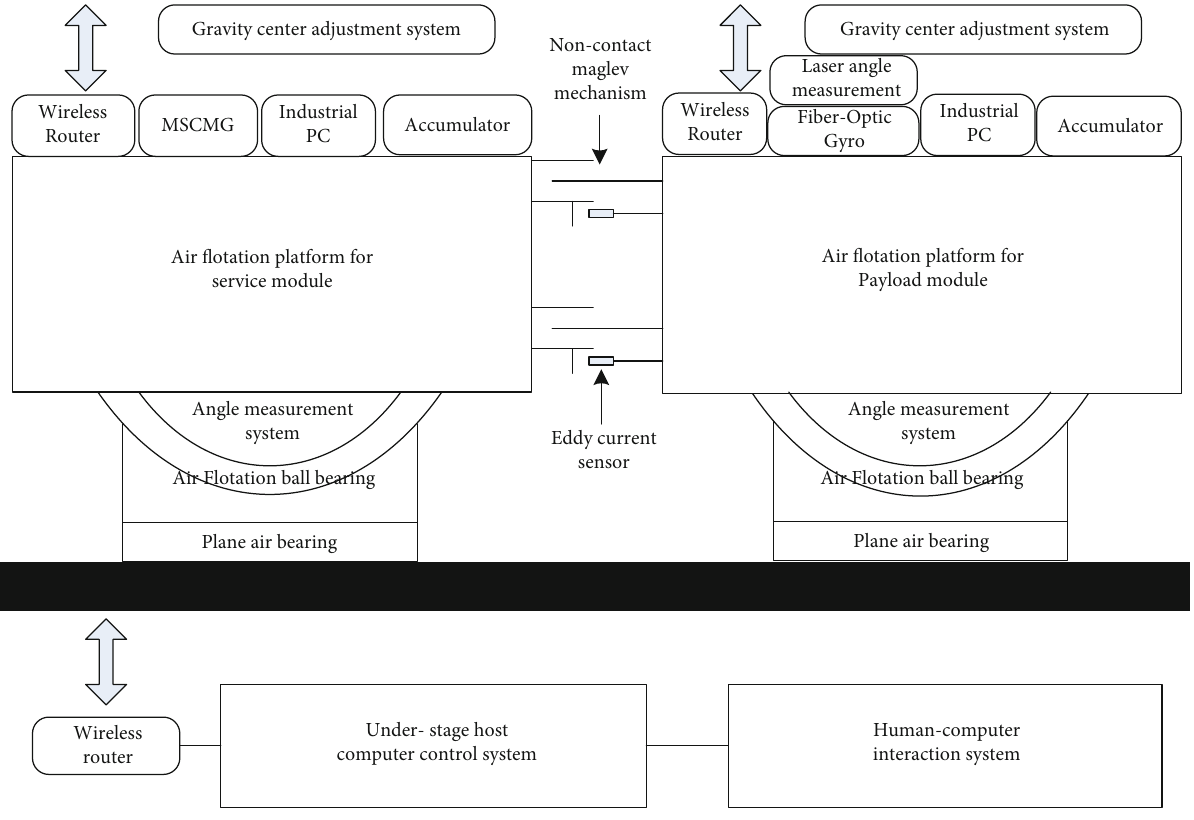
Figure 3: Schematic diagram of test